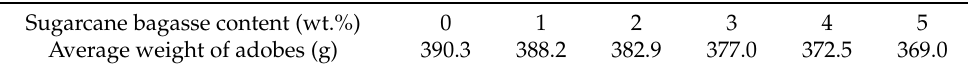
Table 1. Average weight of